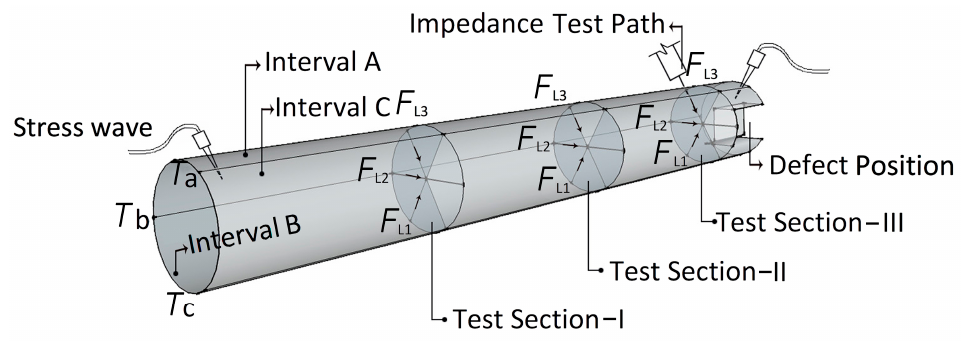
Figure 10. Scaled specimens test data acquisition flowchart.